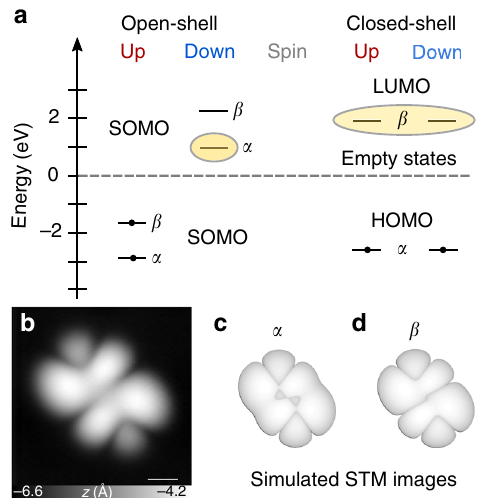
Fig. 5 Spin-polarised DFT calculations. a Energy-level diagram obtained from DFT calculations carried out with the G 0 W 0 approximation. Marked energy levels correspond to the lowest-laying unoccupied states. b Constant-current STM image of IF taken with a metal tip at the energy corresponding to the negative ion resonance (NIR) ( V = 1.0 V and I = 1.0 pA). c , d Simulated STM images of orbitals α ( c ) and β ( d ). Scale bar, 500 considered. α and β are the frontier molecular orbitals of IF . In the closed-shell con fi guration, α is fully occupied (closed) and is the highest occupied molecular orbital, whereas β is the lowest unoccupied molecular orbital. Note that non-polarised energy minimisation also leads to the closed-shell con fi guration. In the open-shell con fi guration, α and β are non-degenerate singly occupied molecular orbitals (SOMOs). We imaged the negative ion resonance (NIR) at positive sample bias, with its onset at V = 1.0 V (Fig. 5b). We were unable to image the positive ion resonance (PIR) because the molecule started to move at increased negative biases before the bias voltage reached the onset of the PIR. Because IF is neutral, the NIR is attributed to electron tunnelling into the lowest-lying empty state(s) of the free molecule 42 . In the closed-shell case, the NIR is expected to closely resemble the shape of the LUMO (orbital β ), whereas in the open- shell case, the NIR is related to the empty spin-down channel of the α orbital (Fig. 5a). In Fig. 5c, d, simulated STM images are shown of orbitals α and β . We considered an extended s -like wave function for the tip to simulate the STM appearance of the simulated LUMO ( β orbital) STM image of the molecule in the closed-shell resonance structure, indicating that IF is in the